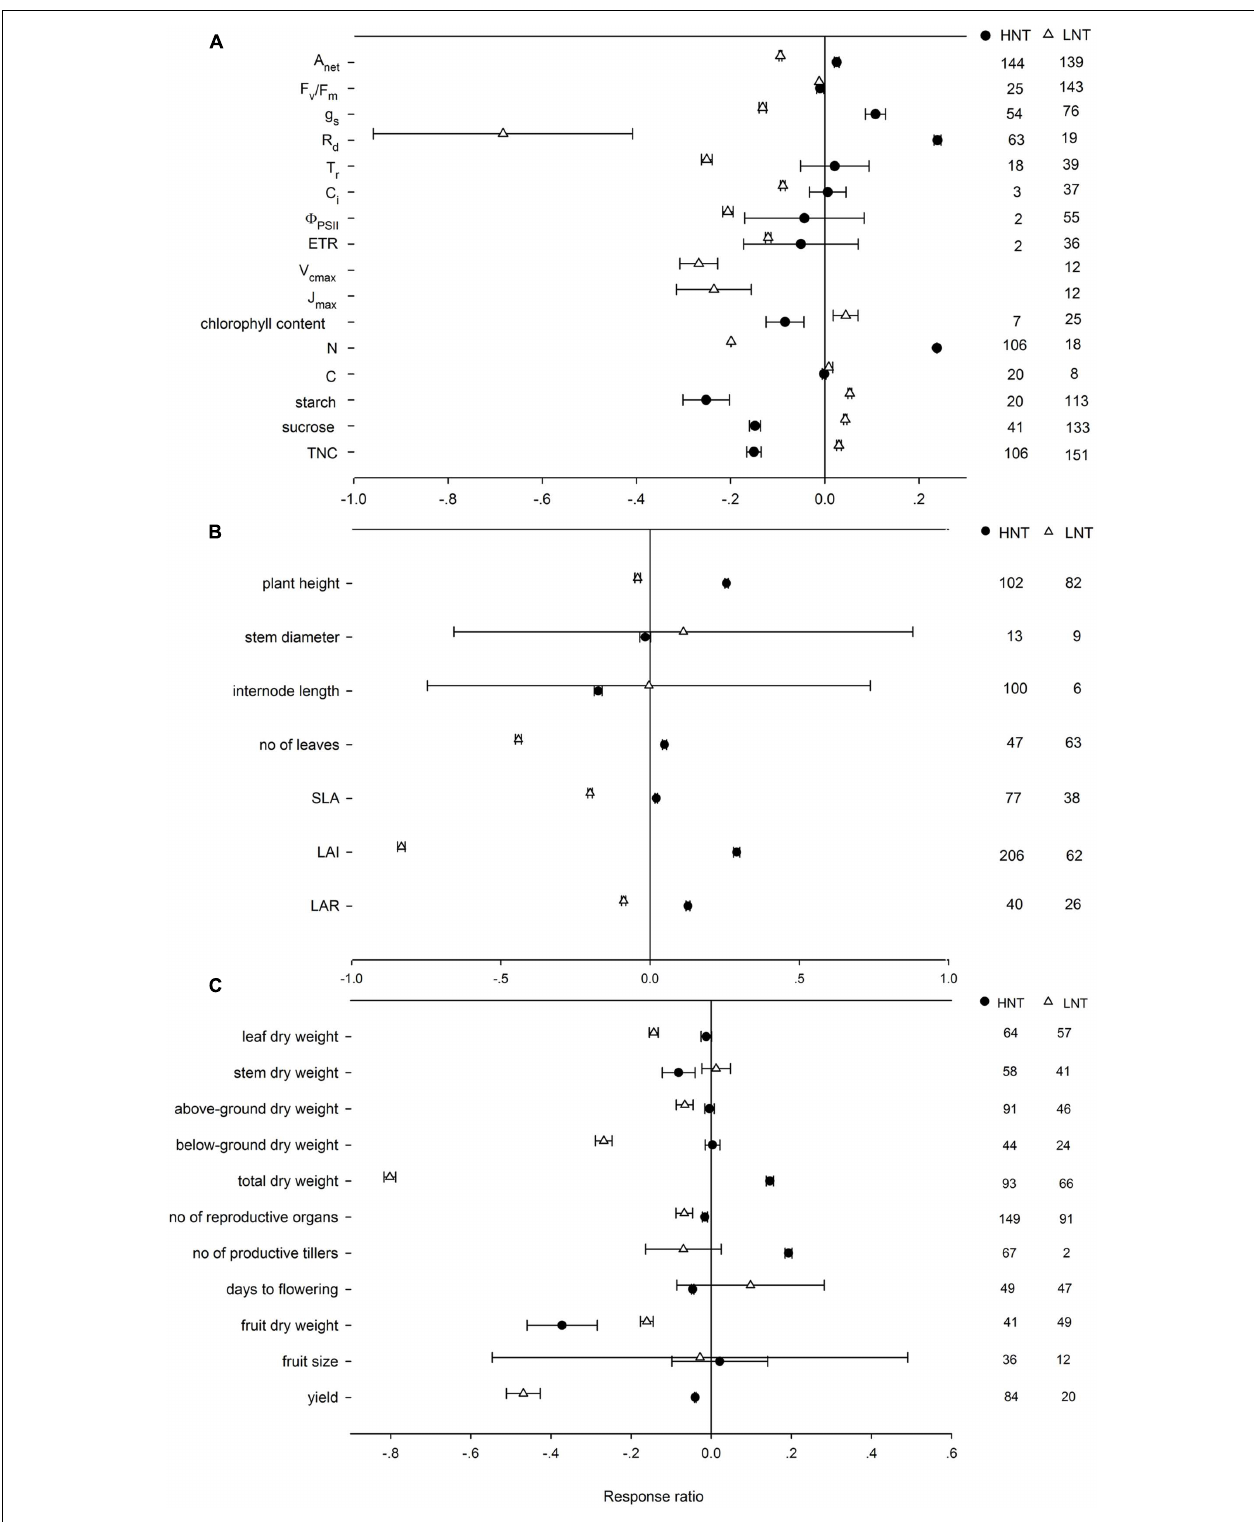
FIGURE 1 | Plant (A) physiological, (B) morphological, and (C) yield-related responses to HNT (filled circles) and LNT (open triangle). Each data point represents the mean ± 95% confidence interval (CI). The number of observations for each variable is given on the right of the graph. Note that N is tissue nitrogen content including stem, leaf, panicle, spike, grain, shoot, root, and total N. C is tissue carbon content including stem, leaf, shoot, root, and total C.